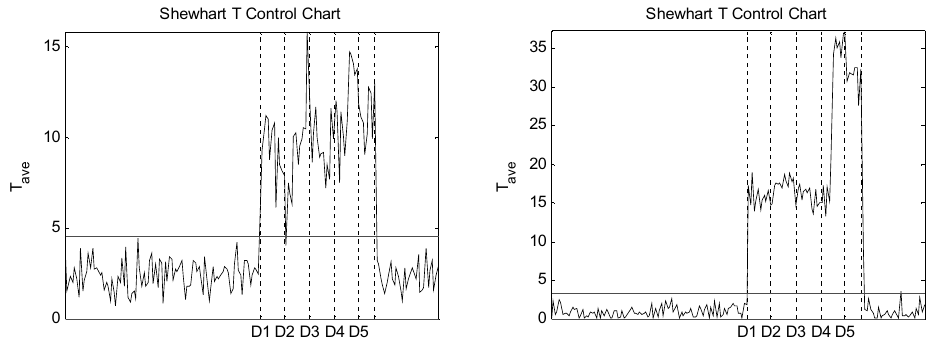
Fig. 8. Damage location 3. Left: AR coefficients. Right: absolute transmissibilities.